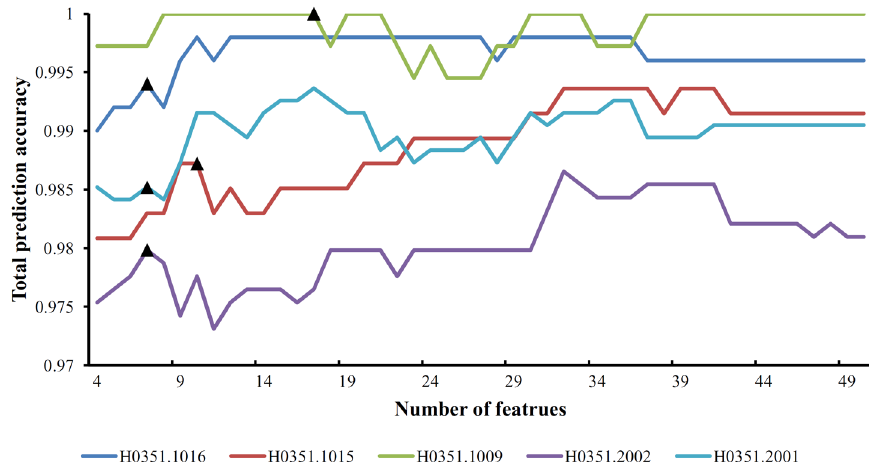
Fig 3. Parts of five IFS-curves using the data of H0351.1012 as the training dataset and the data from other people as the test dataset. The triangle in each curve represents the inflection